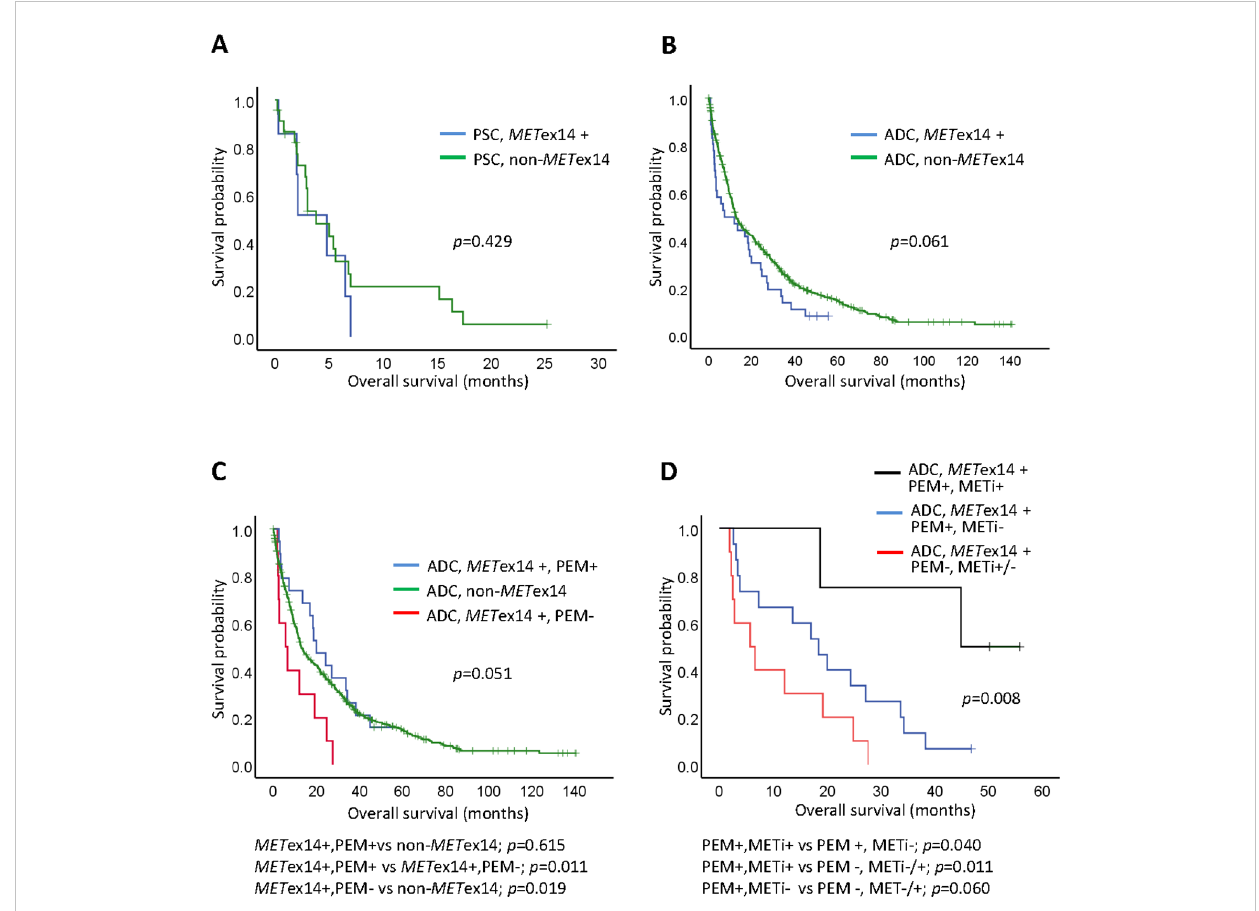
FIGURE 3 Kaplan-Meier curves of overall survival (OS) for Stage IV lung cancers. (A) Pulmonary sarcomatoid carcinoma (PSC) in MET ex14 positive ( MET ex14+) or non- MET ex14 patients; (B) Adenocarcinoma (ADC) patients with MET ex14 ( MET ex14+) or non- MET ex14 patients; (C) ADC patients with MET ex14 who received pemetrexed (PEM+), ADC patients with MET ex14 who did not received pemetrexed (PEM-), and ADC with non- MET ex14 patients; pairwise comparisons for p -value were shown below the panel; (D) ADC patients with MET ex14 who received sequential pemetrexed (PEM+) and MET inhibitor (METi+), who received pemetrexed (PEM+) without MET inhibitor (METi-), and who did not receive pemetrexed (PEM-) and with or without MET inhibitor (METi+/-); pairwise comparisons for p -value were shown below the